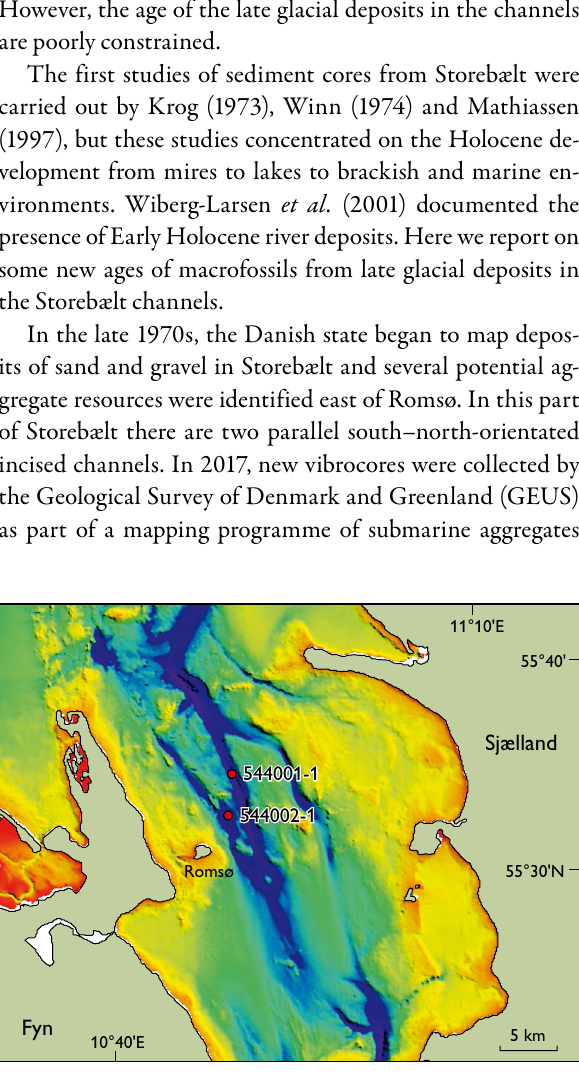
Fig. 2. Bathymetry of the Storebælt region showing the locations of the cores discussed in this paper. Water depth: 0 to c . 50 m. Water depth at core site 544001-1 is 38.5 m, and at core site 544002-1 it is 33.6